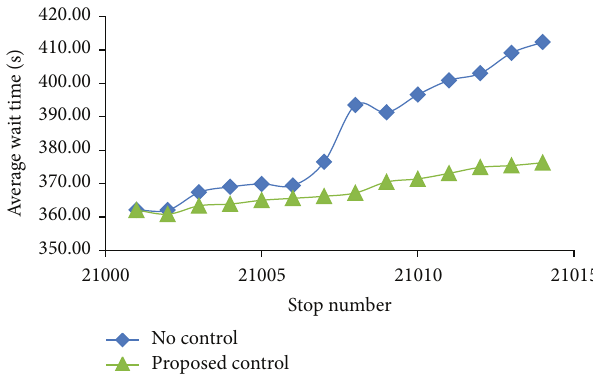
Figure 8: Impact of bus control on average wait time.